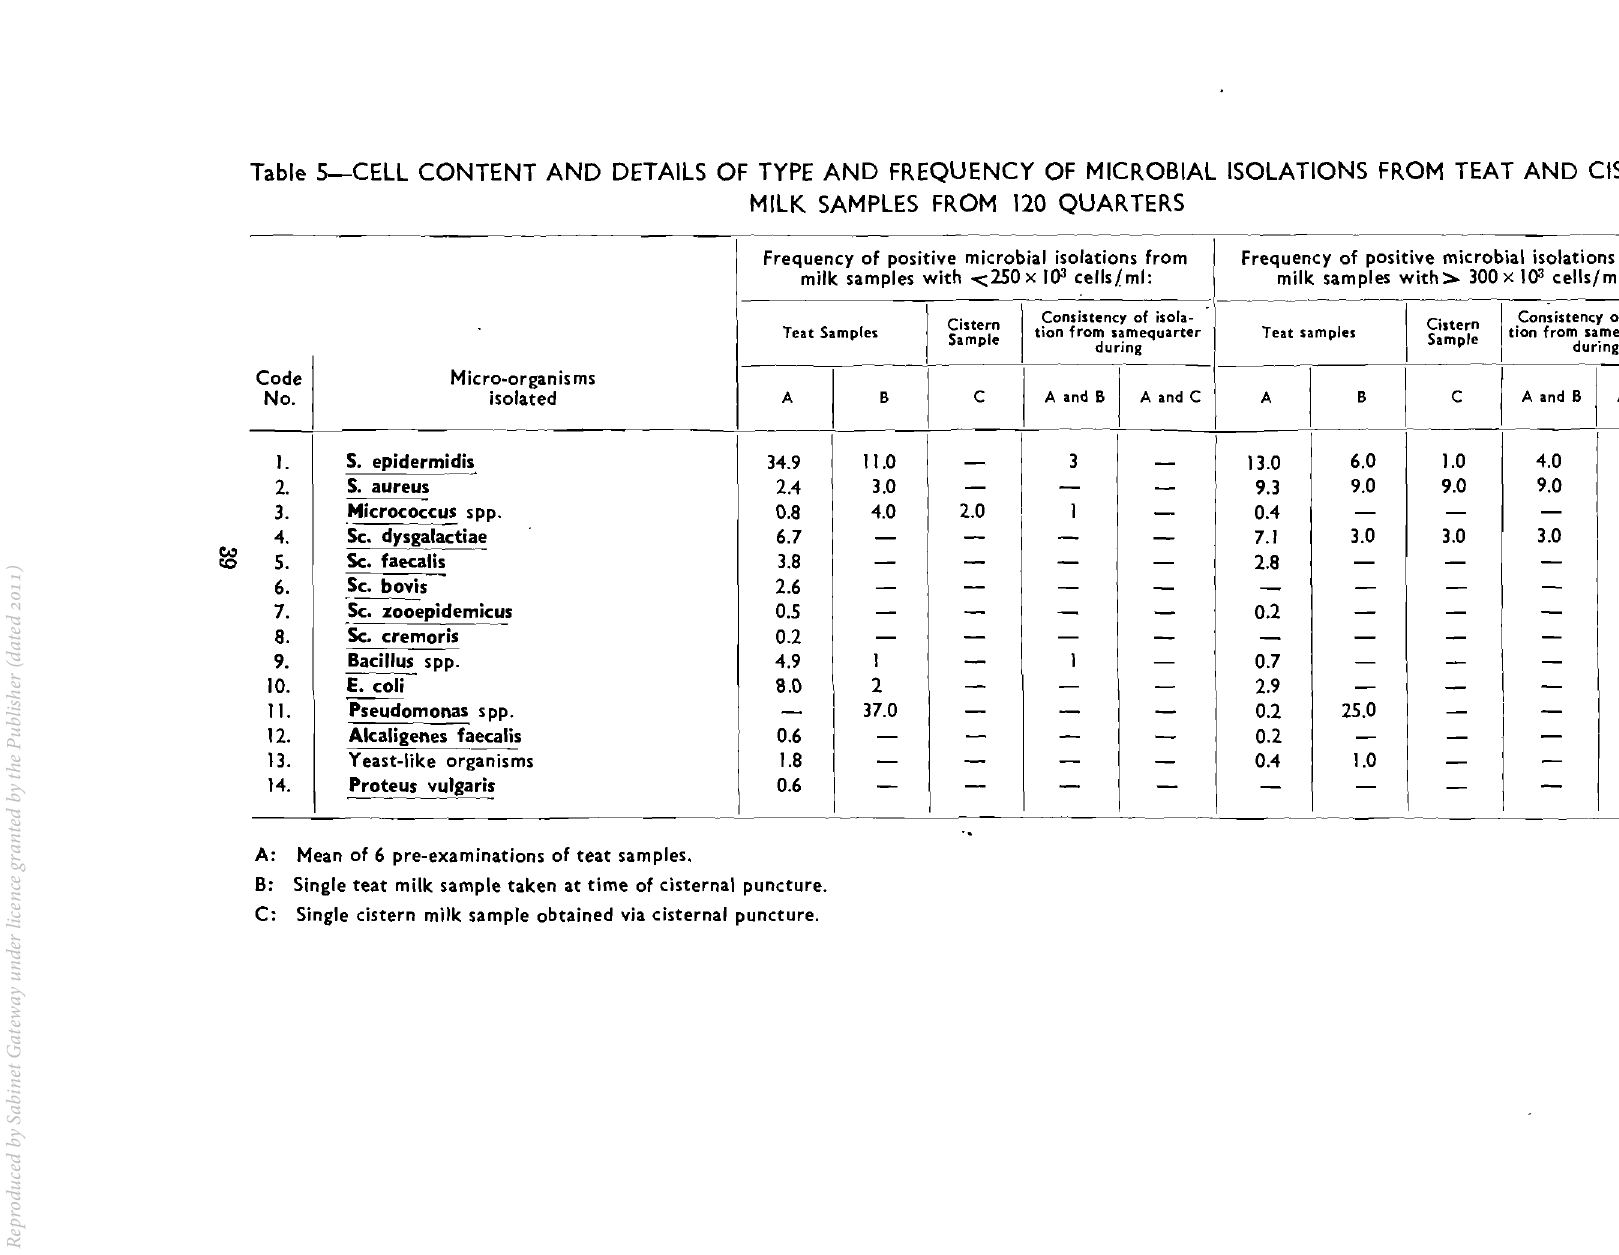
Table S-CELL CONTENT AND DETAILS OF TYPE AND FREQUENCY OF MICROBIAL ISOLATIONS FROM TEAT AND